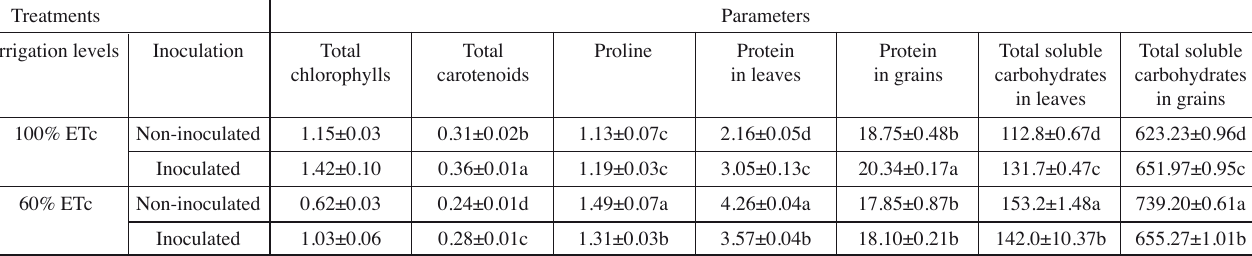
Tab. 4: Effect of Azospirillum lipoferum inoculation on total chlorophylls (mg g −1 FW), total carotenoids (mg g −1 FW), proline (mg g −1 DW), protein in leaves and grains (mg g −1 DW) and total soluble carbohydrates in leaves and grains (mg g −1 DW) of wheat ( Triticum aestivum L., cv. Giza-168) plants grown under non-stressed and drought-stressed